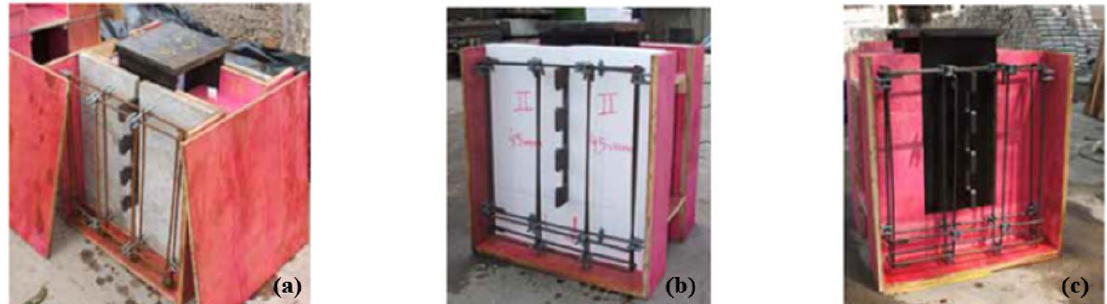
Figure 5. Specimens tested: (a) concrete pre-slab; (b) EPS plate and (c) no pre-slab.